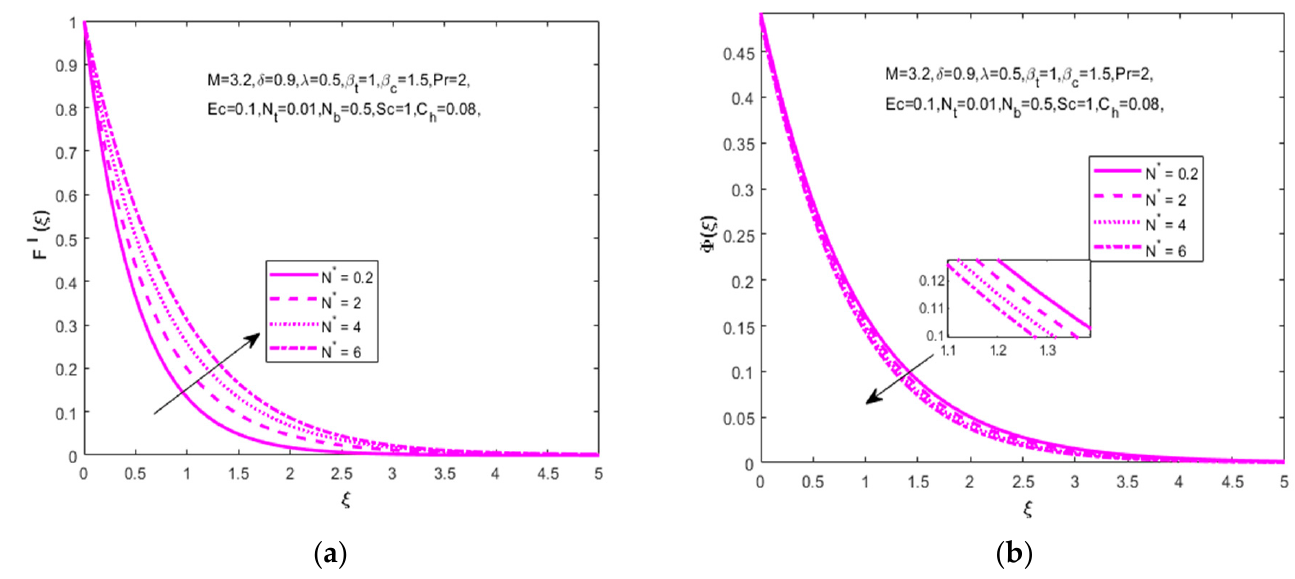
Figure 3. Impact of approximation parameter N ∗ on ( a ) velocity ( F (cid:48) ( ξ )) and ( b ) concentration ( Φ ( ξ )) , respectively.